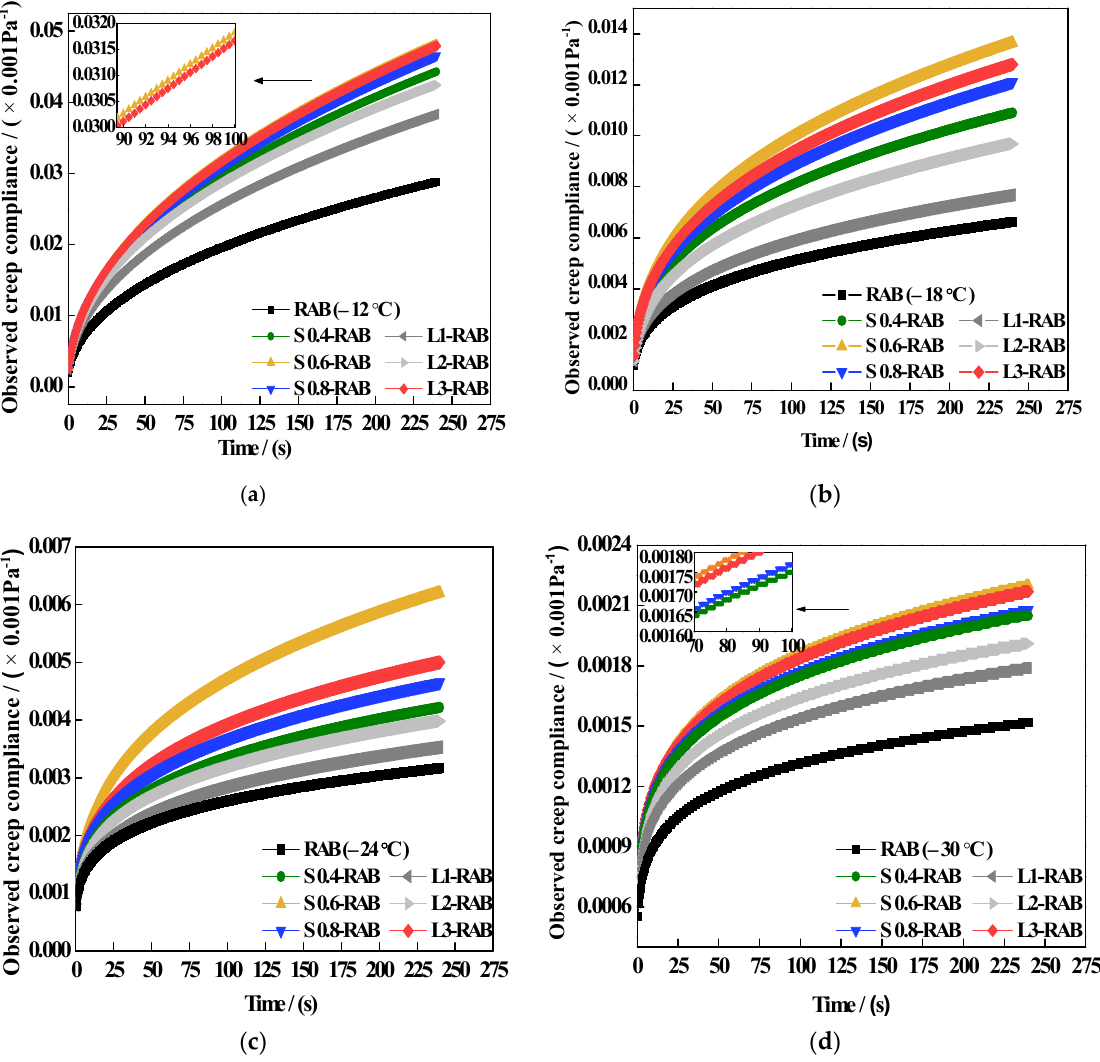
Figure 12. 𝐷(𝑡) values of simple fractional viscoelastic model for W-RABs at ( a ) − 12 ℃ , ( b ) − 18 ℃ , Figure 12. D ( t ) values of simple fractional viscoelastic model for W-RABs at ( a ) − 12 ◦ C, ( b ) − 18 ◦ C, ( c ) − 24 ℃ , and ( d ) − 30 ℃ . ( c ) − 30 ◦ C, and ( d ) − 30 ◦